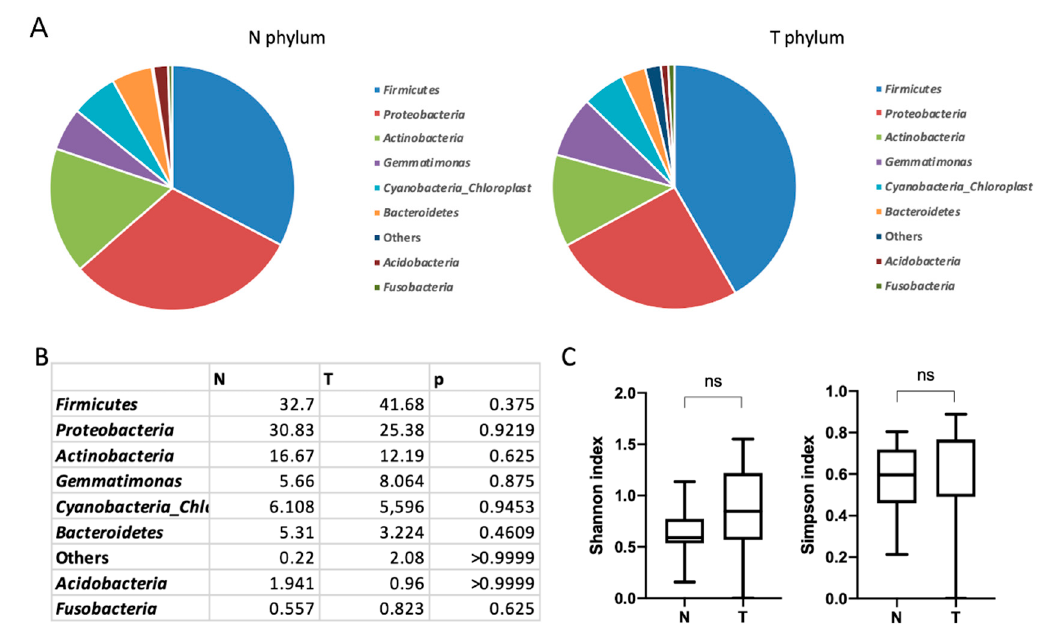
Figure 1. Taxonomic composition of the microbial community of esophageal tissues on the level of phylum. ( A ) Characterization of esophageal squamous cell cancer (ESCC) microbiota. Relative abundance at the phylum level for tumor (T) and normal tissue (N) samples. ( B ) Taxonomic composition. ( C ) Taxonomic α –diversity calculated with Shannon and Simpson indices between N and T groups. ns—non significant.